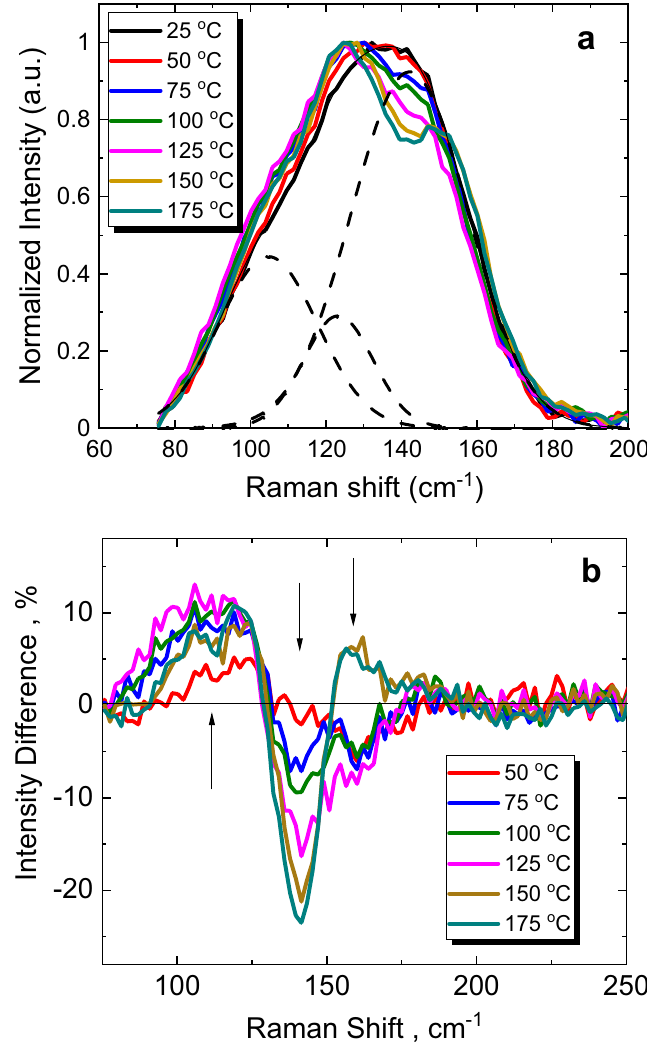
Figure 8. ( a ) Unpolarized Raman spectra of amorphous Ge 15 Sb 40 S 15 Se 15 Te 15 thin film recorded at different temperatures show typical pattern of Te-based complexes (they are dominated in Raman signal of the investigated glasses). The example of unrestricted Gaussian fit (dashed lines) performed for the signal at 25 °C shows features common to other GST materials. ( b ) Difference between the Raman spectra at